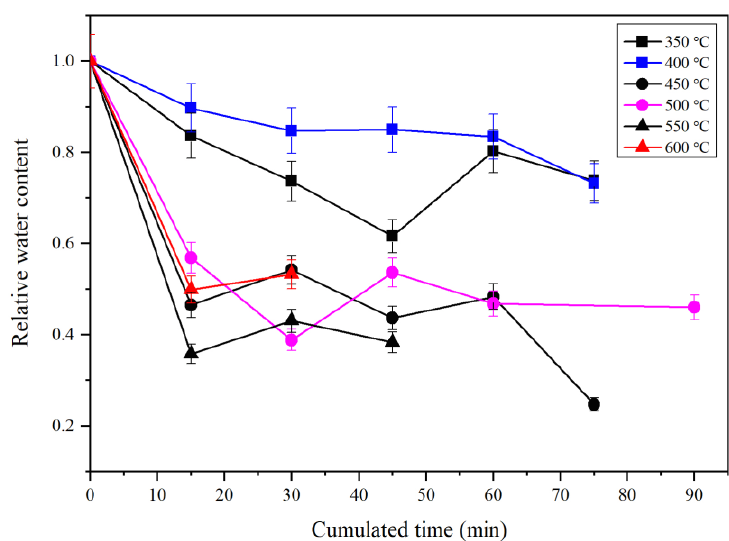
Figure 12. Variation of water content ( C H2O ) of the Mg-Rw crystal plates with cumulated annealing time at different T (°C). All data are for the crystal plates made from the intermediate-H 2 O Mg-Rw crystals.